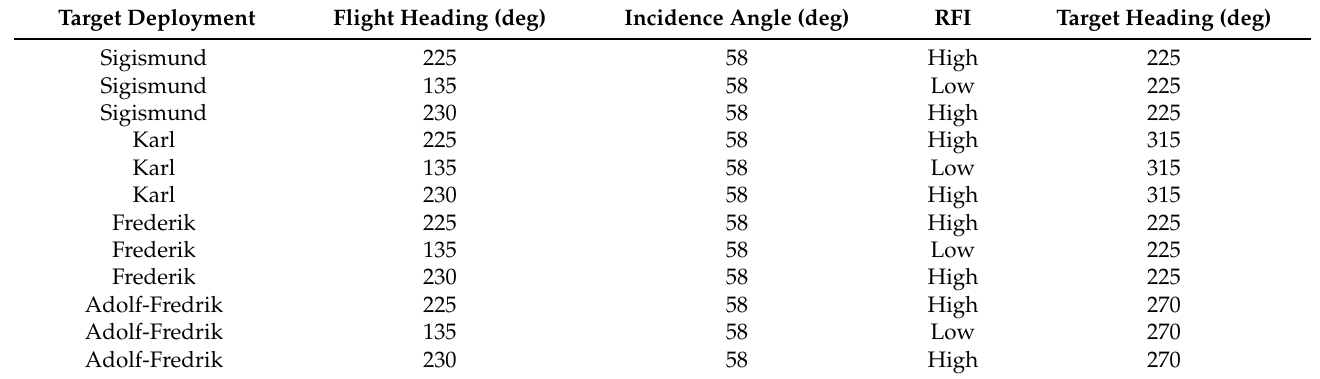
Table 1. Mission configurations of CARABAS-II VHF-Band SAR dataset.